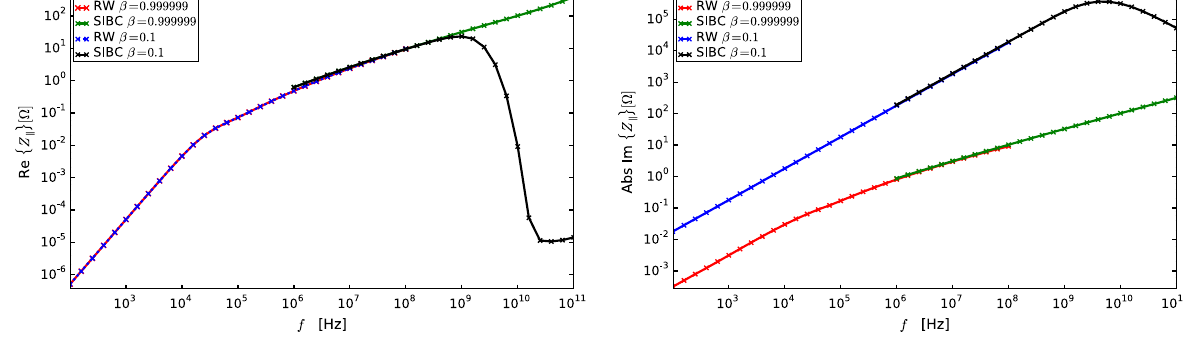
FIG. 11. Longitudinal impedance of the collimator.